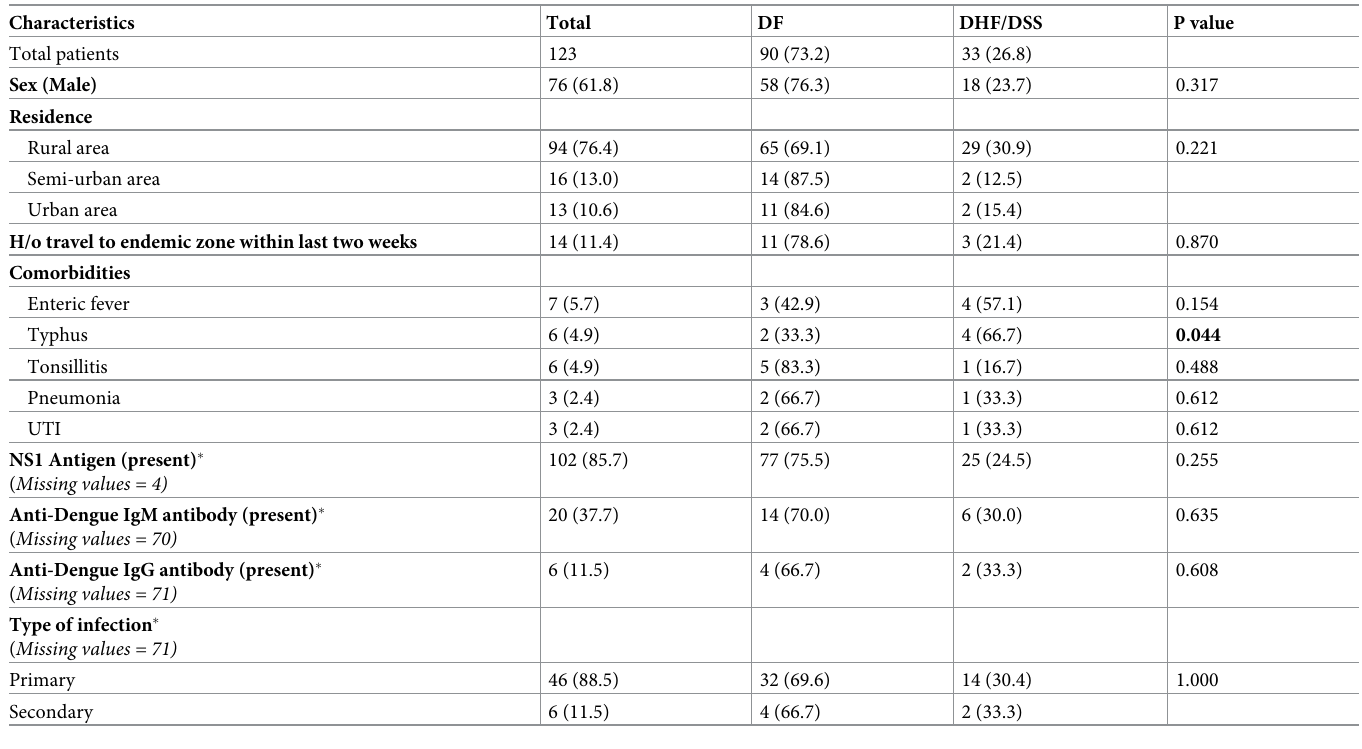
Table 1. Demographic, serological and co-morbidity profile of children with dengue.